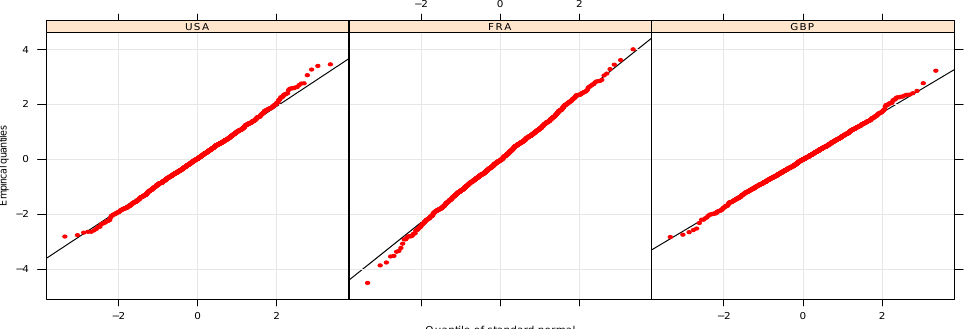
Figure A2. QQ-plots: Visual inspection of the normality of the residuals. Drawing of the QQ-plots is based on 100 Monte-Carlo simulations and comparisons between the obtained empirical quantiles of ξ s with the theoretical quantiles of a centered Gaussian i.i.d. random